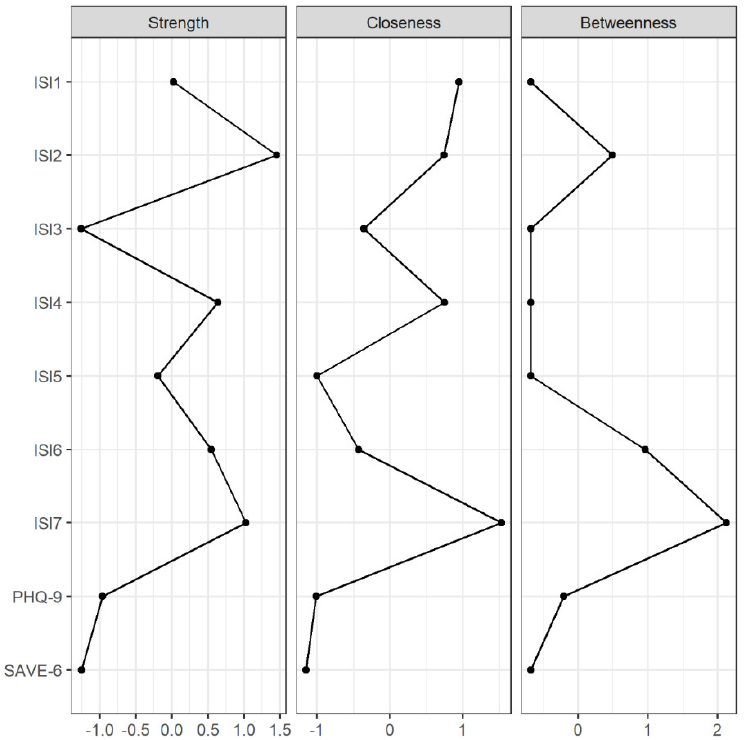
Figure 2. Strength, closeness, and betweenness centralities of each node of the network.